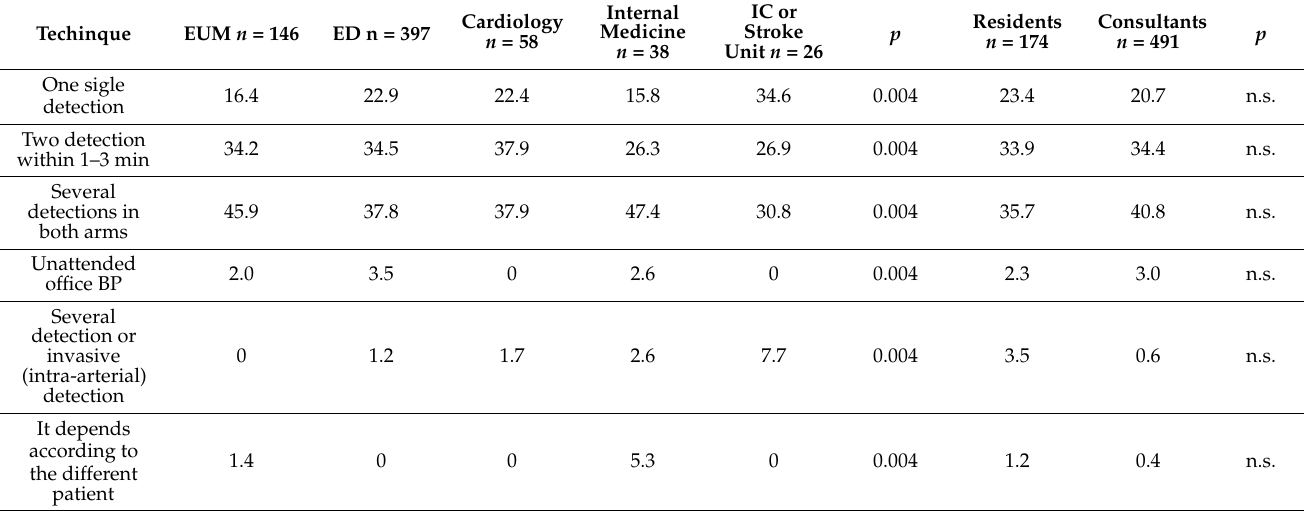
Table 2. Techniques used to detect BP levels by department and qualification level.